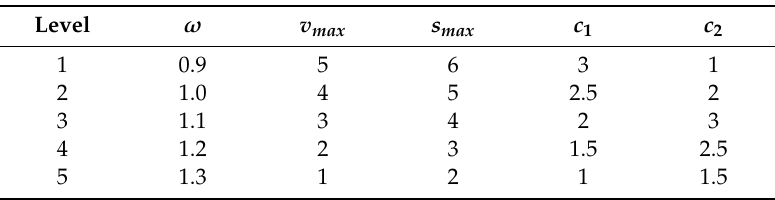
Table A5. PSO algorithm parameters